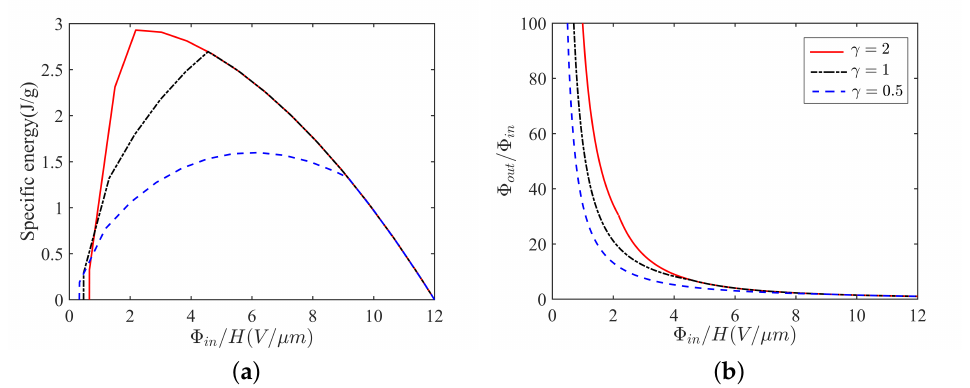
Figure 6. Specific energy ( a ) and amplification of voltage ( b ) for cycles represented by various rectangles in Figure 5 by using different ratios γ =